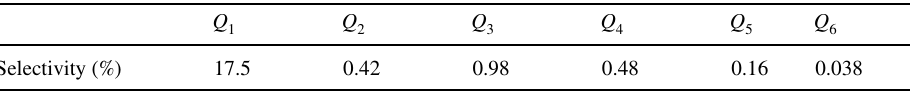
Table 3 Selectivity of Q 1 – Q 9